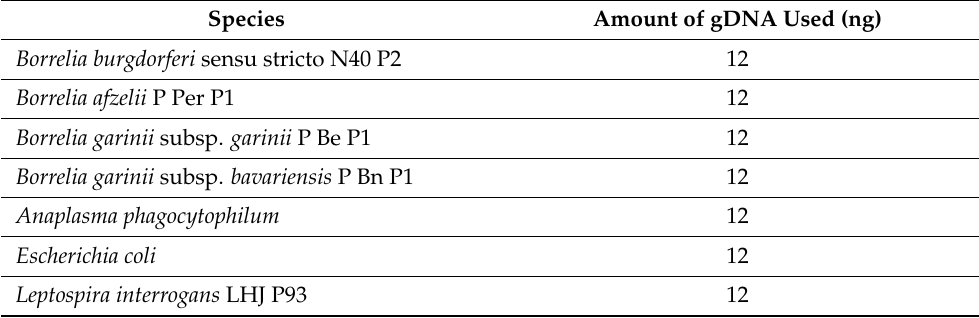
Table 5. Species and amount of gDNA used for mock community. Species Amount of gDNA Used